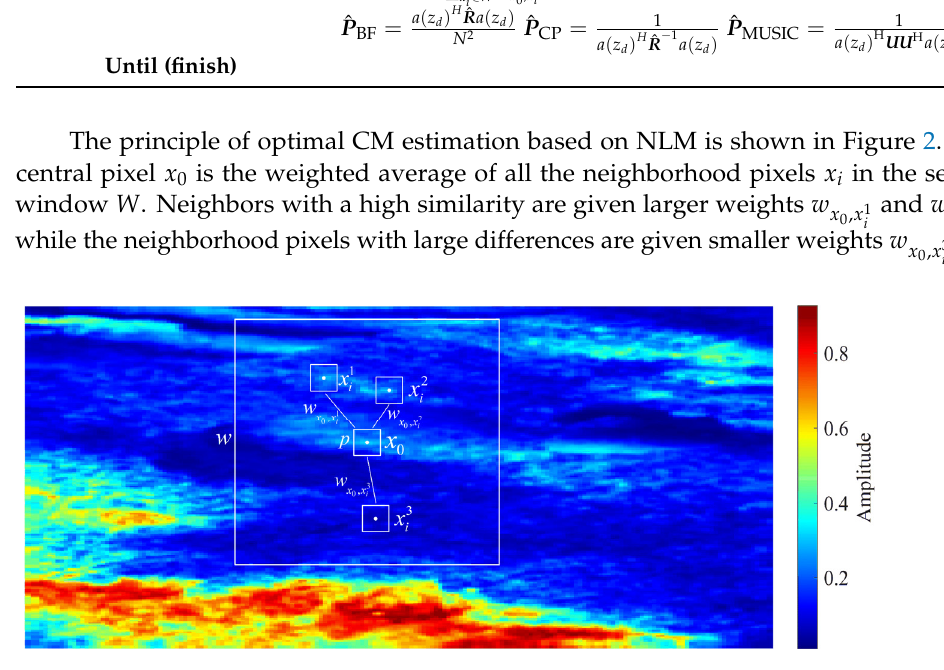
Figure 2. The principle of optimal CM estimation based on NLM ( p represents the size of the matching window, and (cid:1875) denotes the size of the search window).